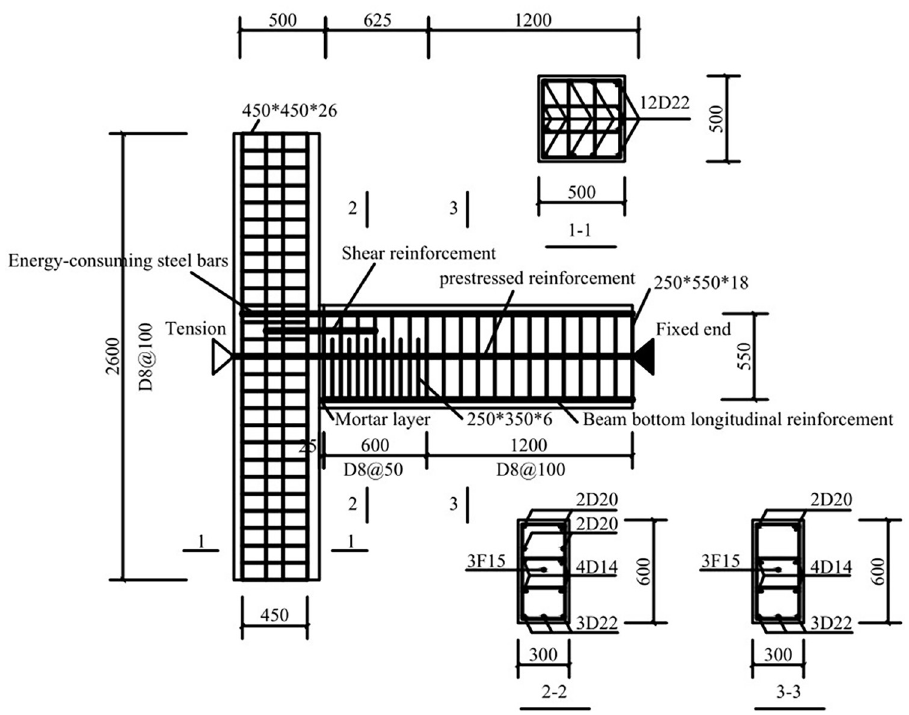
Fig 2. Specimen reinforcement details (SJ-1 as an example).